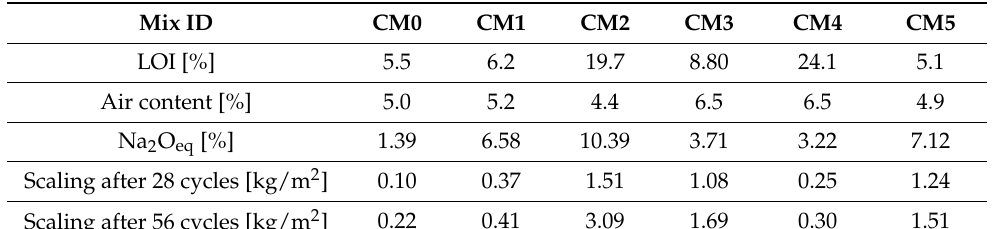
Table 10. The material loss at the test surface of specimens with 15 wt% WBA due to freeze–thaw attack in the presence of de-icing salts.